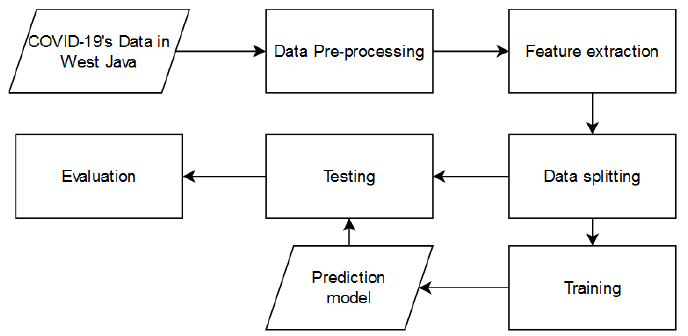
Fig. 1. The methodology of Time Series Prediction of Novel Coronavirus COVID-19 Data in West Java Fig. 1 depicts the predicted number of new cases in this investigation. In the preprocessing phase, the timestamp as the